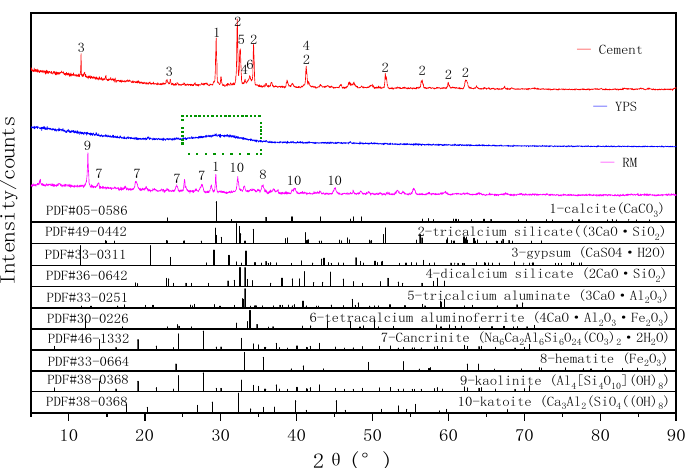
Figure 1. X ‐ ray diffraction (XRD) patterns of red mud (RM), yellow phosphorus slag (YPS), and cement (1: calcite (CaCO 3 ), 2: tricalcium silicate (3CaO ∙ SiO 2 ), 3: gypsum (CaSO 4 ∙ H 2 O), 4: dicalcium silicate (2CaO ∙ SiO 2 ), 5: tricalcium aluminate (3CaO ∙ Al 2 O 3 ), 6: tetracalcium aluminoferrite (4CaO ∙ Al 2 O 3 ∙ Fe 2 O 3 ), 7: Cancrinite (Na 6 Ca 2 Al 6 Si 6 O 24 (CO 3 ) 2 ∙ 2H 2 O), 8: hematite (Fe 2 O 3 ), 9: kaolinite (Al 4 [Si 4 O 10 ](OH) 8 ), 10: katoite (Ca 3 Al 2 (SiO 4 ((OH) 8 ). Table 1. The main chemical composition of the raw materials.